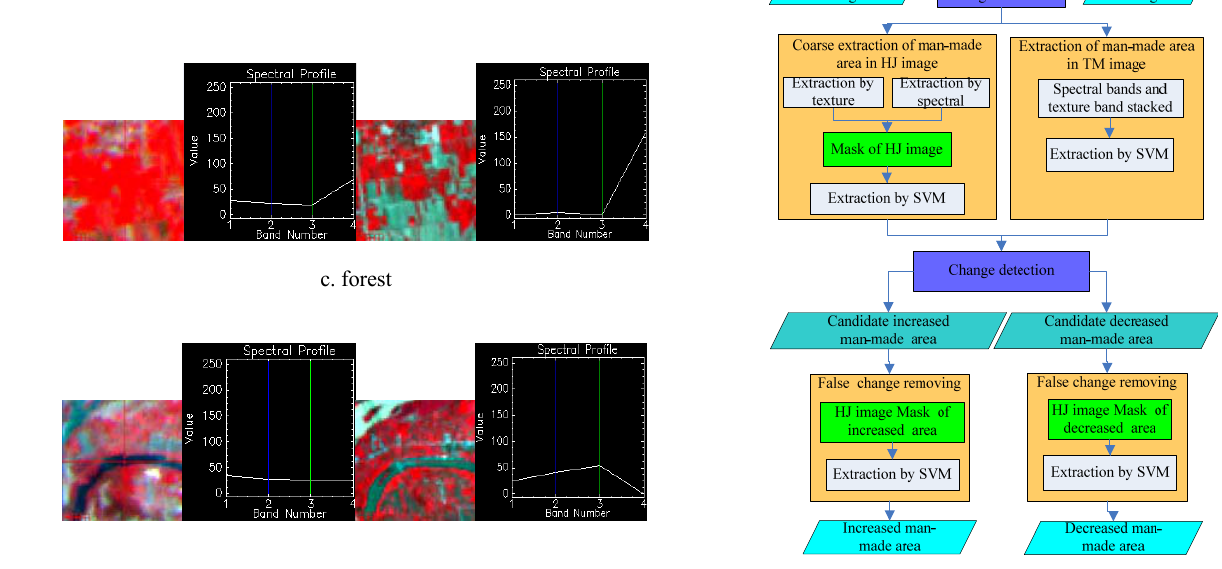
Fig.1 Spectral curses of several typical features in HJ image and TM image